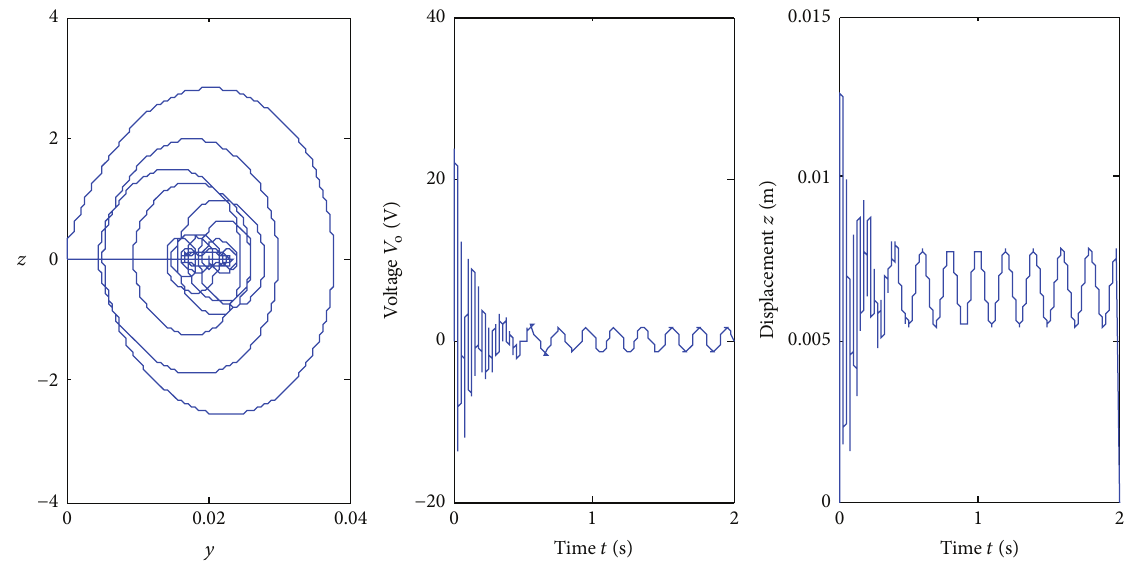
Figure 7: A periodic motion around a stable position when 𝑓 = 5 Hz.